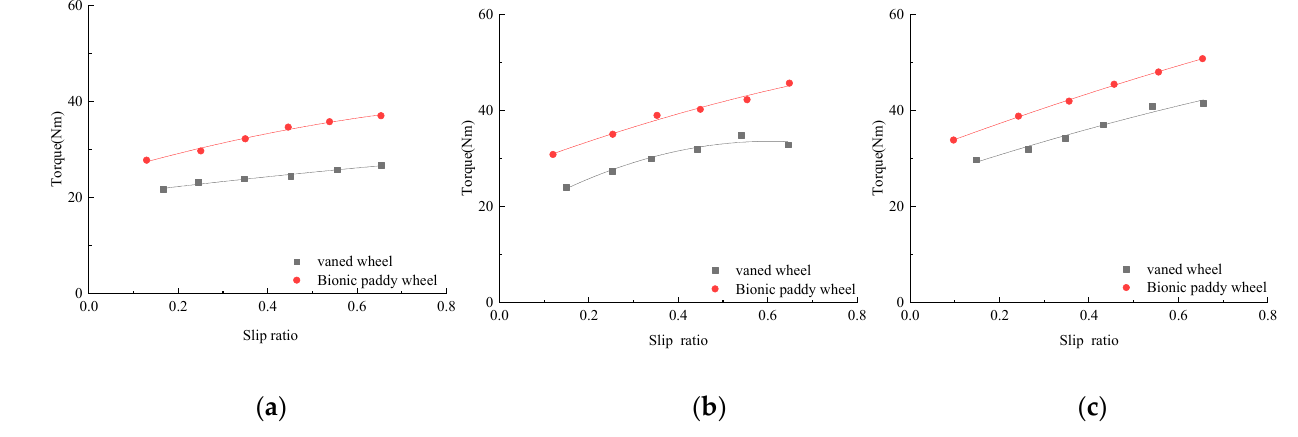
Figure 4. The comparison of torque and slip ratio of different wheels. ( a ) Wheel load 58.57 N, ( b ) wheel load 84.57 N, ( c ) wheel load 107.4 N.